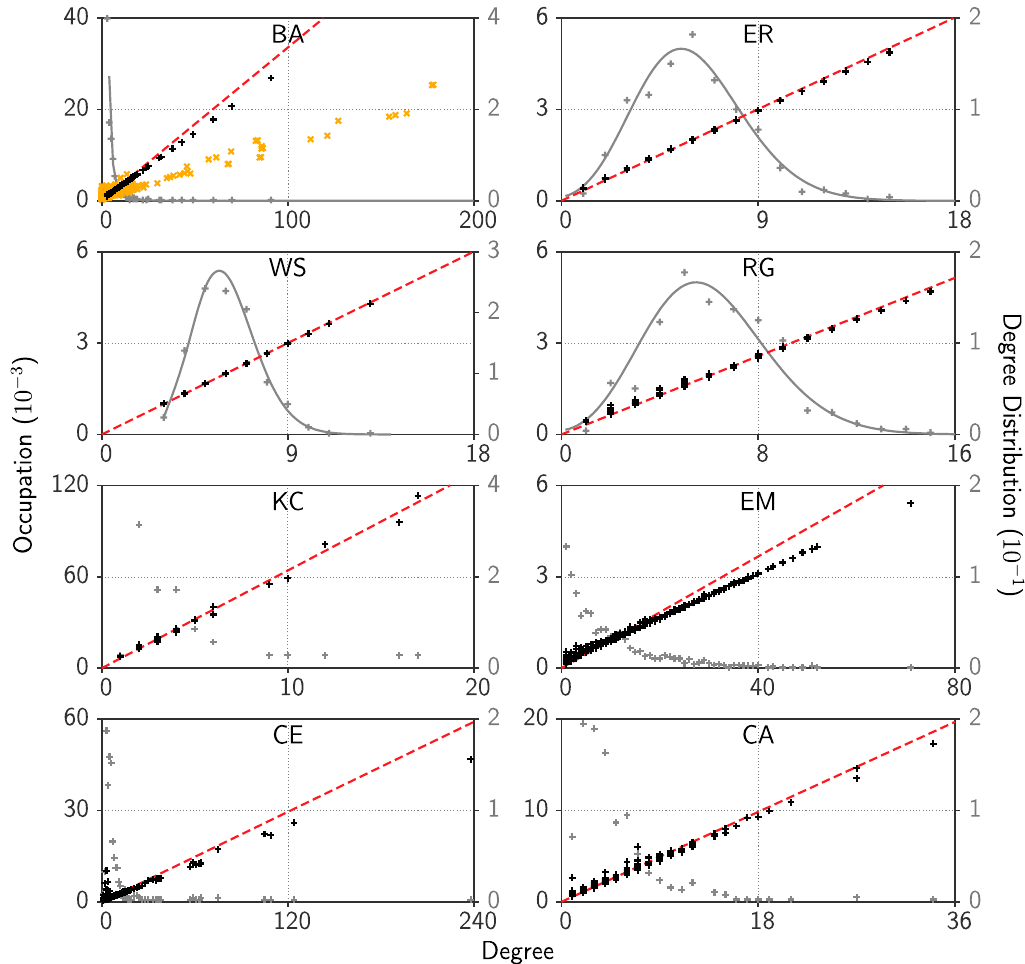
FIG. 2. Long-time average probability and degree for nodes in a complex network. Eight networks are considered: BA, ER, WS, RG, KC, EM, CE, and CA. We plot the classical ð P C Þ i (red dashed line) and quantum ð P Q Þ i (black +) probabilities against the degree d i for every node i . We overlay this with a plot of the average degree distribution P ð d Þ against d for each network type (grey solid line), when known, along with the distribution for the specific realization used (grey +). Alongside the BA network, we also plot ð P Q Þ i for the optimized BA (BA-opt) network, in which the internode weights of the BA network are randomly varied in a Monte Carlo algorithm to reach " ¼ 0 : 6 (orange x). We do not include a plot of the degree distribution for this